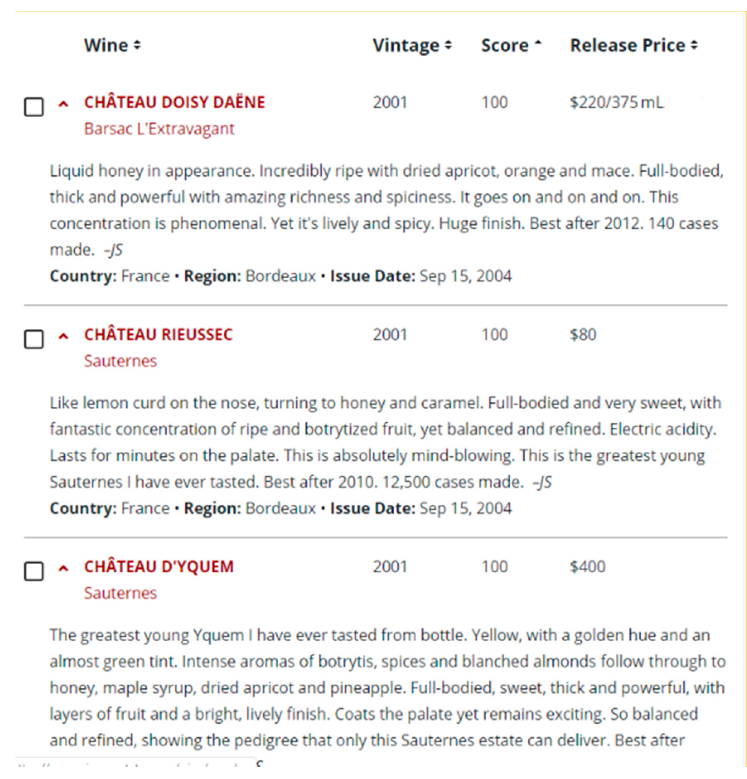
Figure 1. The example of wine reviews on WineSpectator.com.